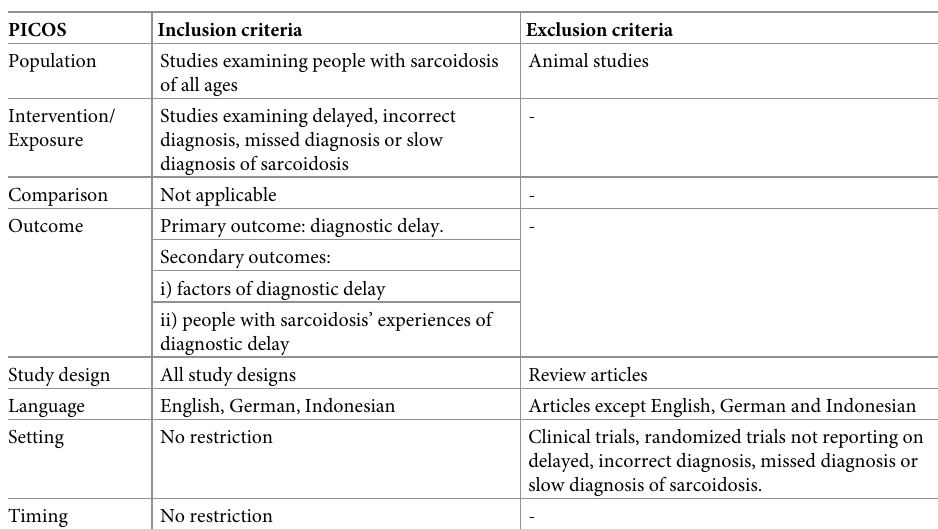
Intervention/Exposure . Studies about delayed diagnosis, incorrect diagnosis, missed diagno- sis or slow diagnosis of sarcoidosis. Comparison . Given the nature of the study there will be no comparison group. Outcomes . Studies that have measures on diagnostic delay, factors of diagnostic delay, and people with sarcoidosis’ experiences of diagnostic delay.